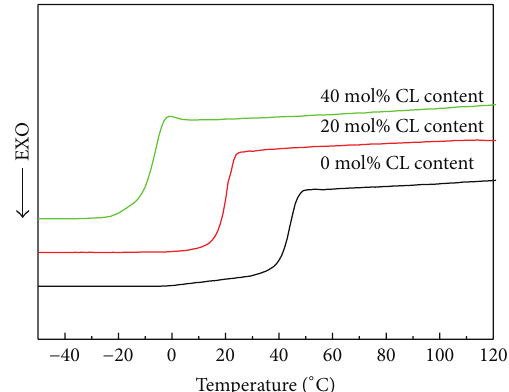
Figure 2: The DSC thermograms of PLGC copolymers.